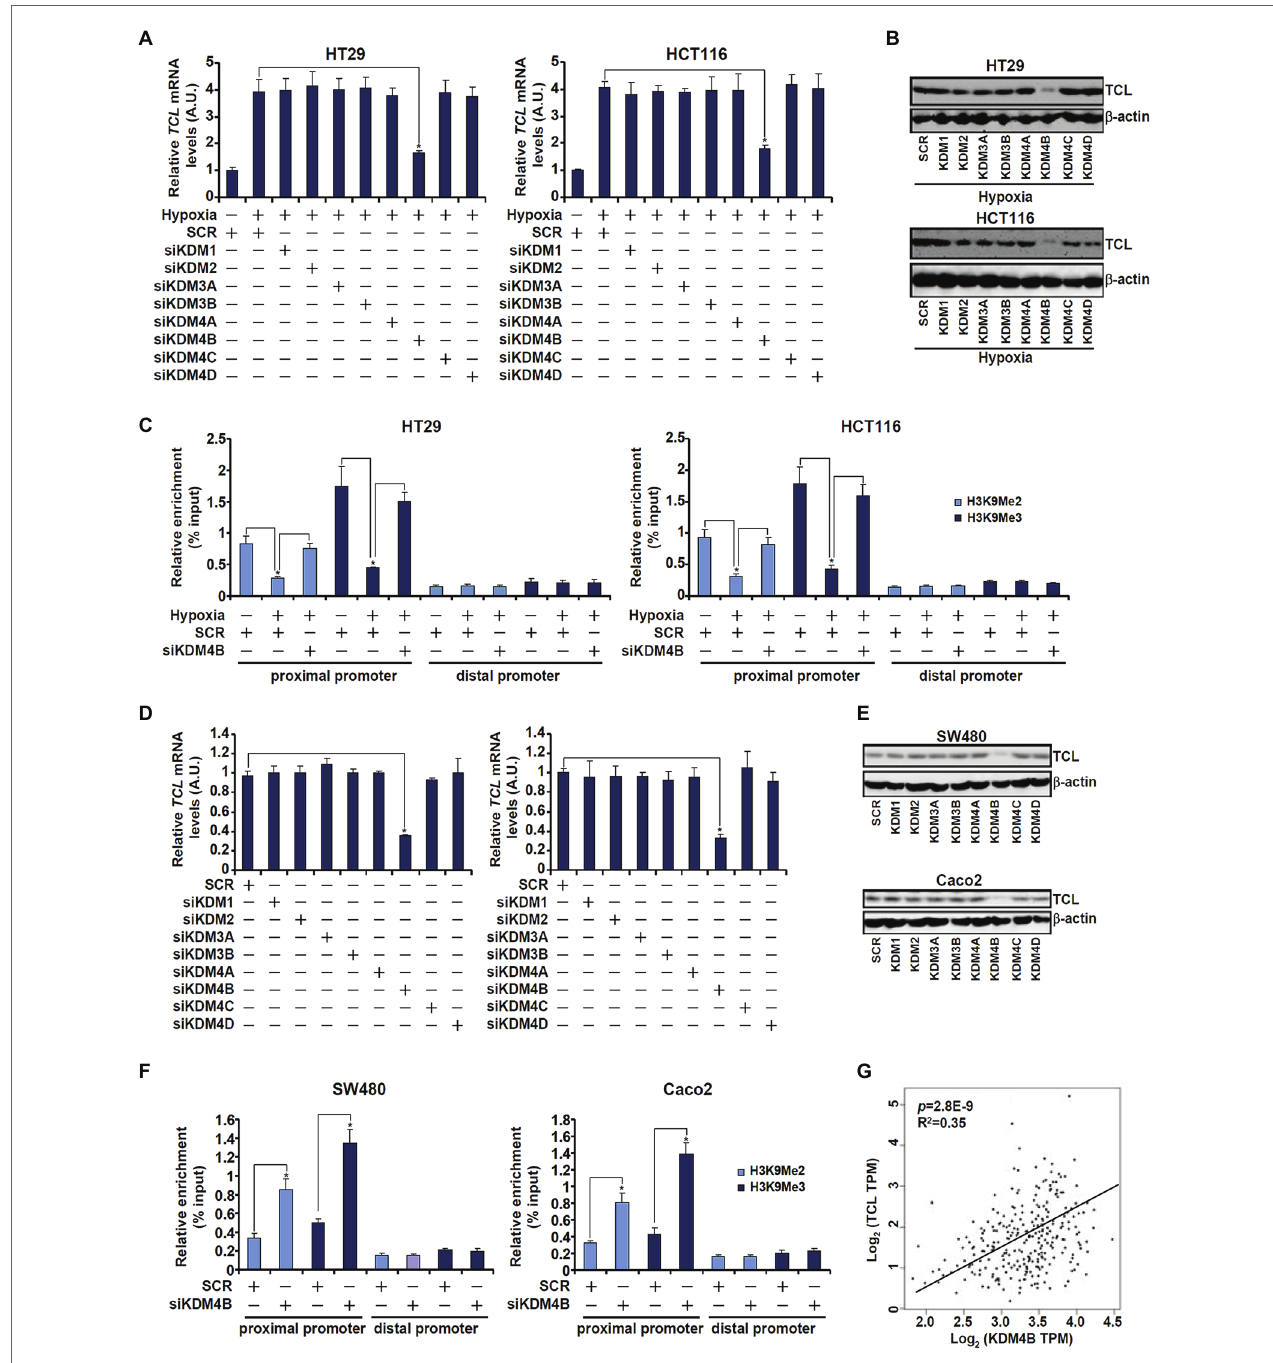
FIGURE 2 | KDM4B regulates TCL transcription in CRC cells. (A–C) HT29 and HCT116 cells were transfected with indicated small interfering RNAs (siRNAs) followed by exposure to hypoxia. TCL expression levels were examined by qPCR and Western. ChIP assays were performed with anti-H3K9Me2 and anti-H3K9Me3. (D–F) SW480 and Caco2 cells were transfected with indicated siRNAs. TCL expression levels were examined by qPCR and Western. ChIP assays were performed with anti-H3K9Me2 and anti-H3K9Me3. (G) Expression data of KDM4B and TCL were extracted from TGCA to draw the scatter plot. Pearson correlation co-efficient was